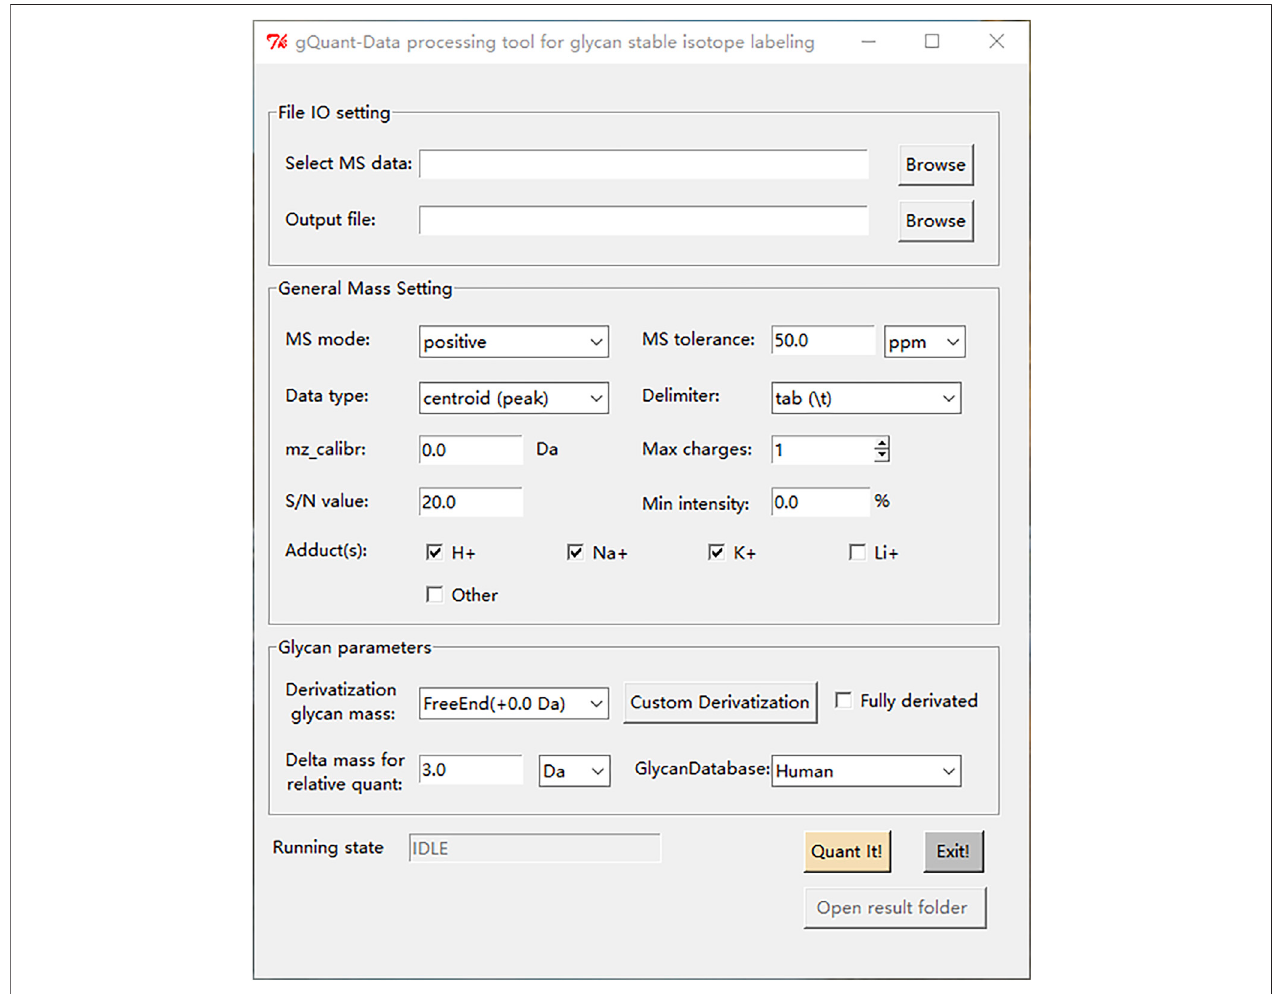
FIGURE 4 | The graphical user interface of